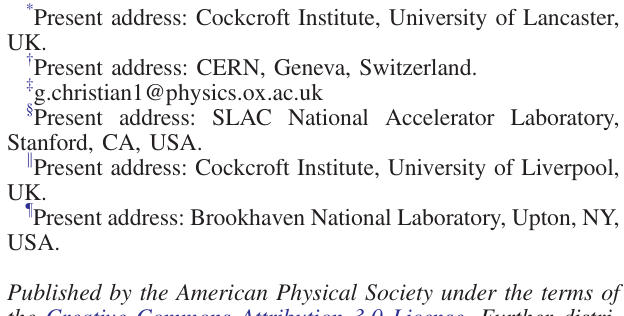
FIG. 1. Layout of the ATF, showing the locations of the ATF2 extraction line and the FONT5